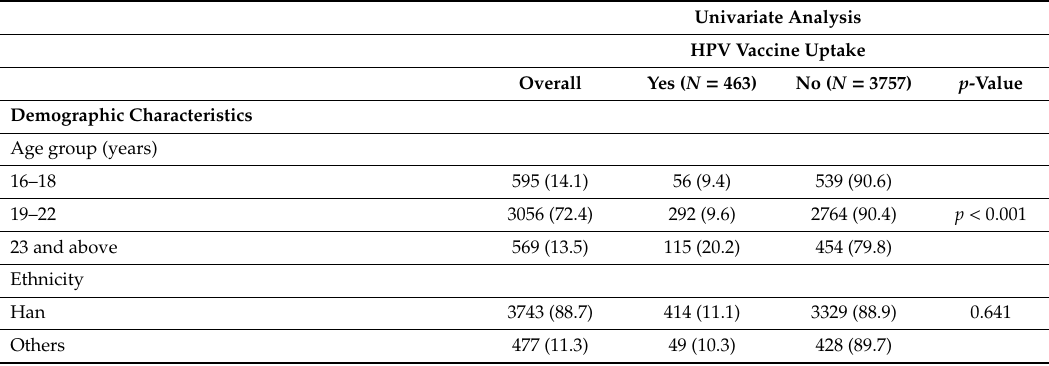
Table 1. Demographic characteristics and univariate analyses of factors associated with HPV vaccine uptake ( N =